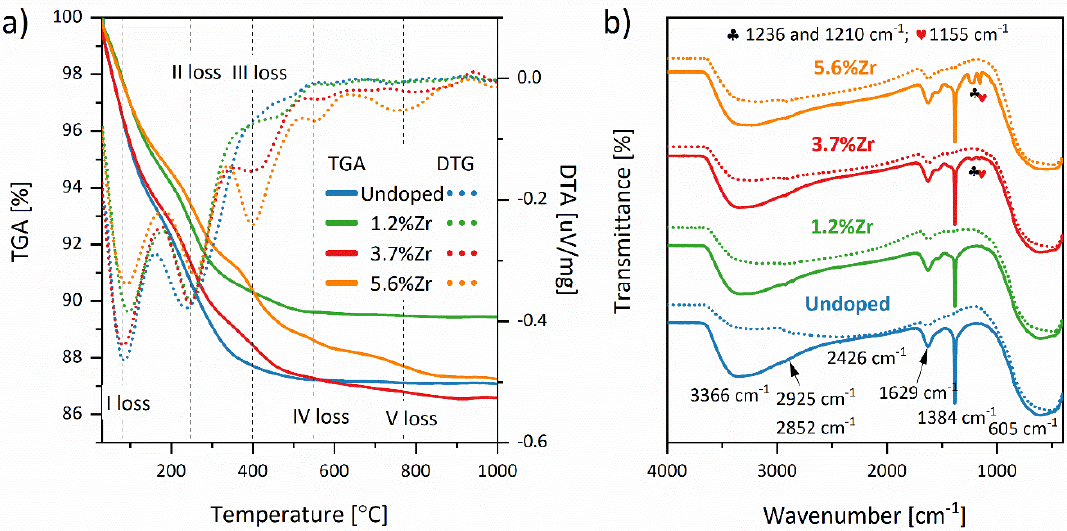
Figure 7. TGA and DTG thermograms of TiO 2 nanoparticles after drying at 60 ◦ C ( a ), and FTIR spectra of materials dried at 60 ◦ C (straight line) and annealed at 450 ◦ C for 2 h (dotted line) ( b ).